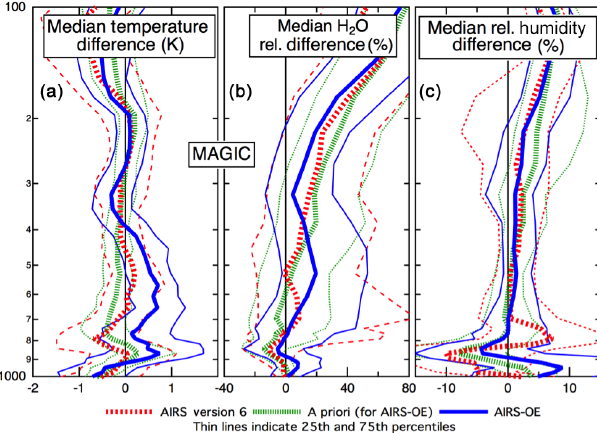
Figure 13. MAGIC sonde launch locations that were matched to coincident AIRS observations. Points are colored by the number of QC-passed AIRS-OE retrievals of water vapor at 321mb. AIRS observations were within 3h and 100km of the sonde launch.